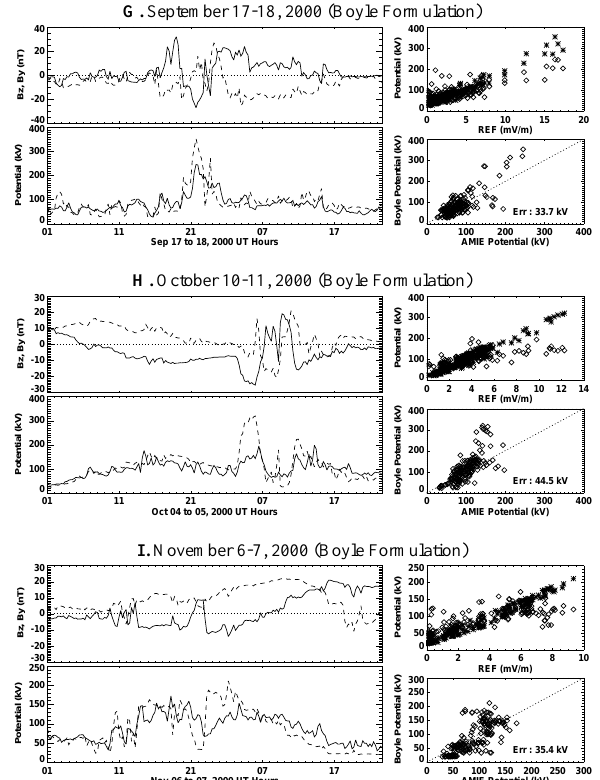
Fig. 3. Three more events in the same format as Figure 1.